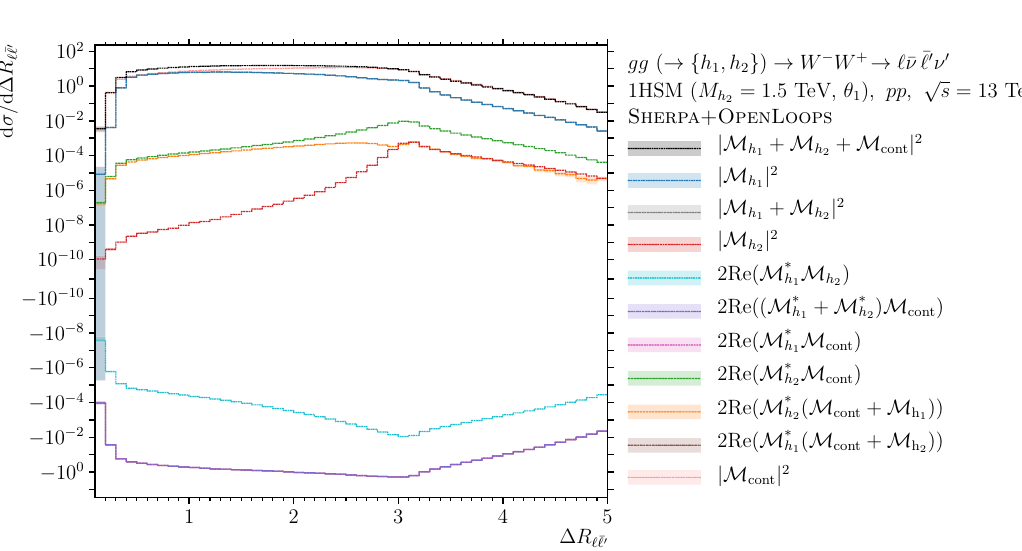
Figure 8 . ∆ φ distributions for the signal process gg ( (cid:31) ¯ (cid:31) (cid:31) = 1500 GeV, θ 1 ) including its interference with the background in pp collisions at the 1HSM ( M h 2 √ s = 13 TeV. Other details as in figure 4.